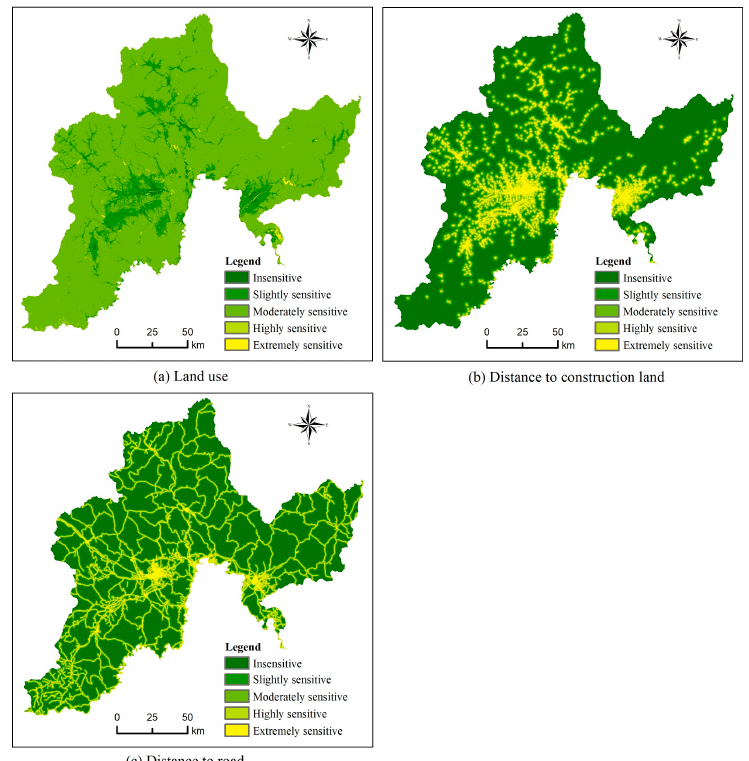
Figure 4. Distribution of ecological sensitivity of human disturbance.